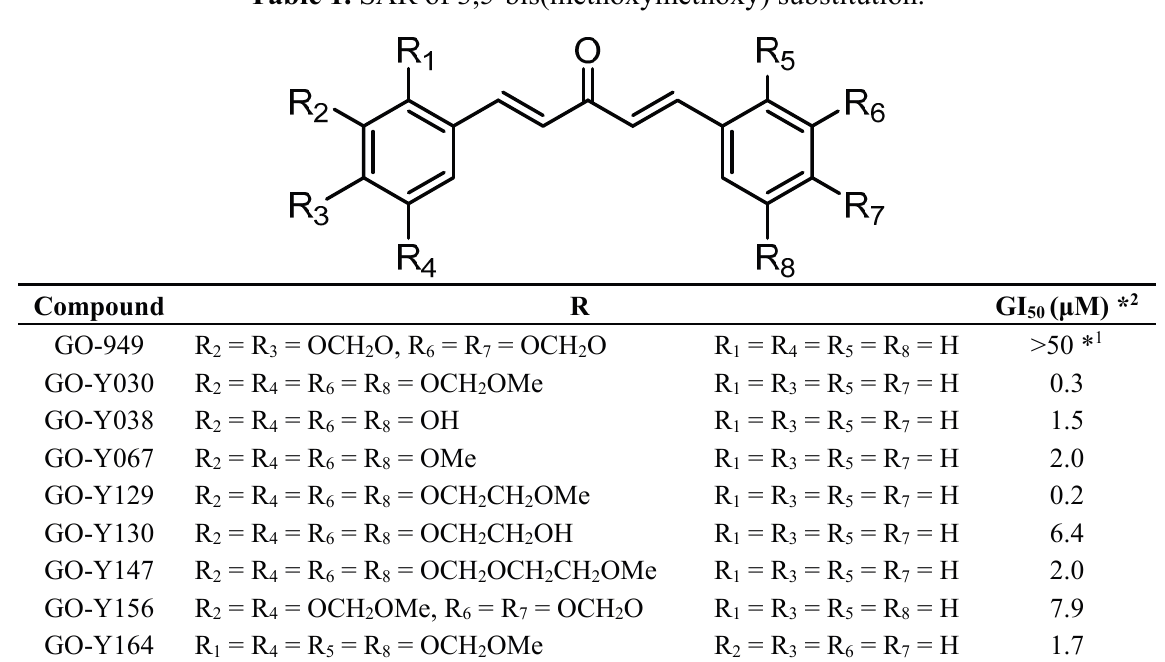
Table 1. SAR of 3,5-bis(methoxymethoxy)